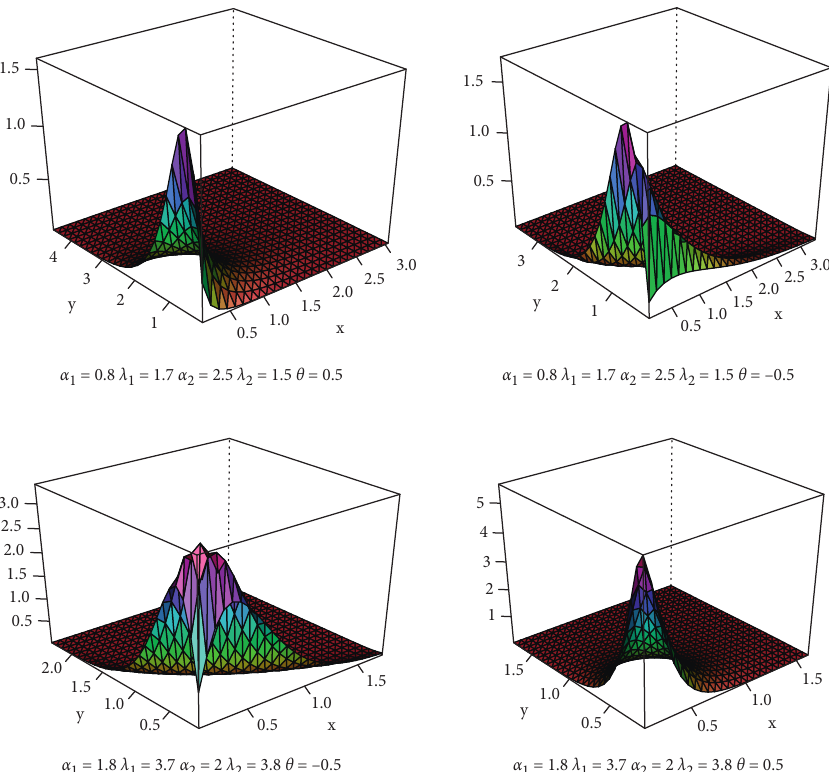
Figure 1: The plot of the BMEE pdf model for varying parameter choices in equation (4).